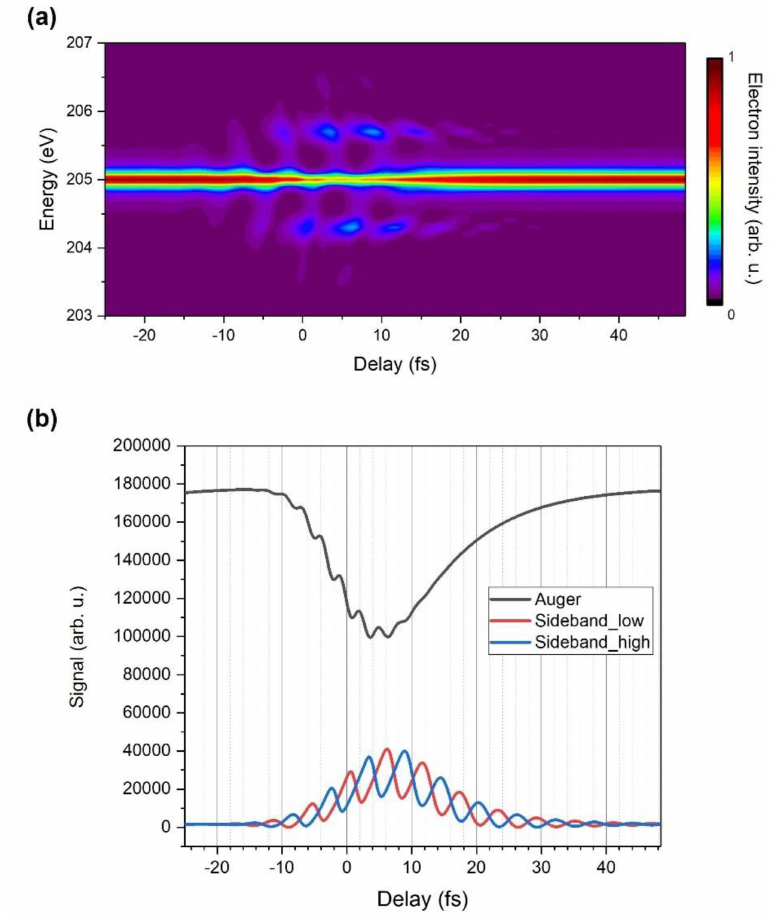
Figure 2. Theoretical calculation [23]. ( a ) Simulated streaking spectrogram of an argon Auger decay channel. ( b ) The envelopes of the calculated Auger and sideband